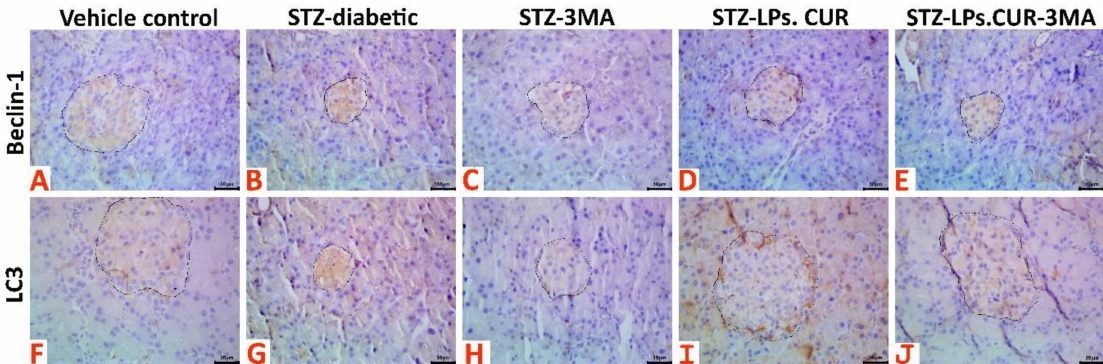
Figure 8. Representative photomicrograph of Beclin-1 stained ( A – E ) and LC3 stained ( F – J ) pancreatic tissue sections showing upregulation of both biomarkers’ immunoexpression in the STZ-diabetic animals, notable upregulation of both biomarkers in the STZ-LPs-CUR treated animals, and downreg- ulation of both biomarkers’ immunoexpression in the 3MA, and STZ-LPs.CUR-3MA treated